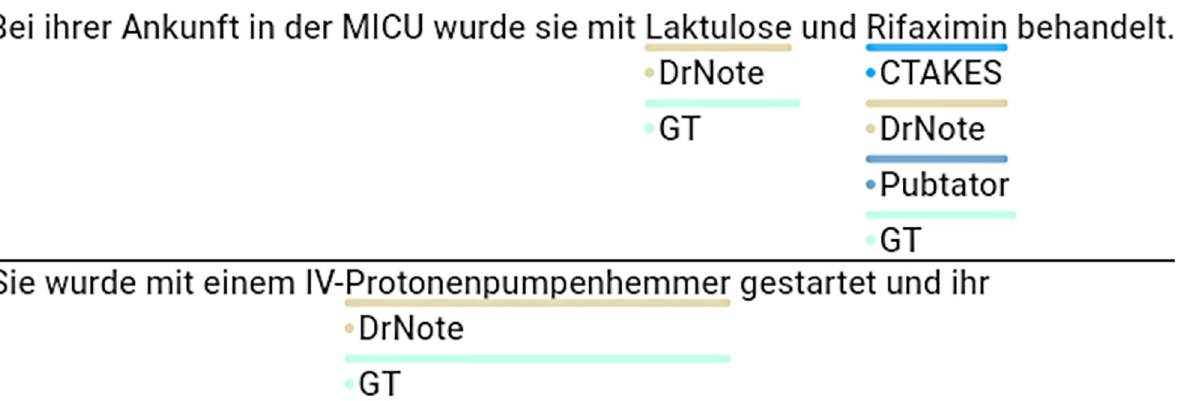
Fig 4. Comparative Sample 1 and 2. Specialized German term missing in UMLS or MeSH, ( Laktulose , Protonenpumpenhemmer , cTAKES & PubTator).